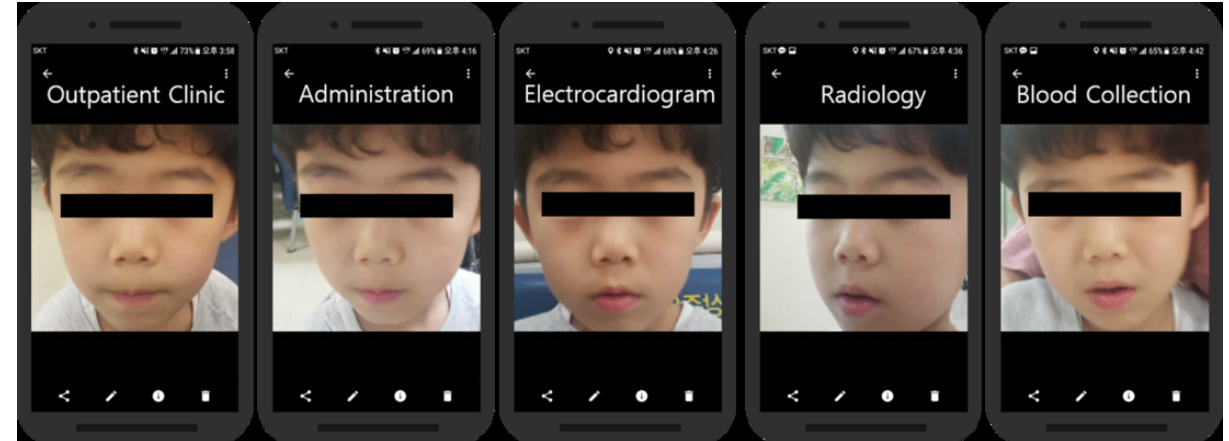
Figure 4. Verified outpatient's input images in various